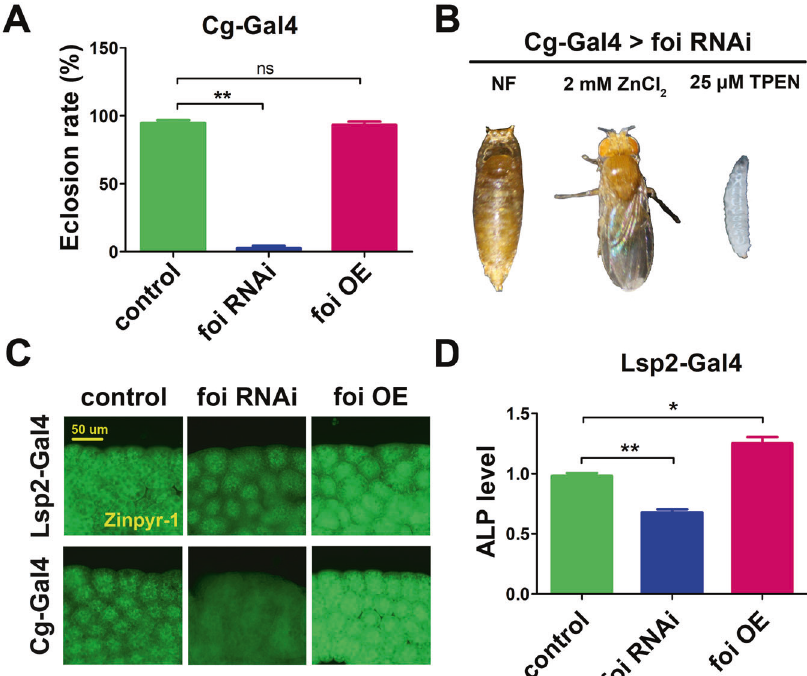
Fig. 1 Foi maintains zinc homeostasis in the fat body and modulates the development of Drosophila melanogaster . A Fat body-speci fi c foi knockdown ( Cg-Gal4 > foi RNAi ) resulted in dramatically reduced eclosion rate in Drosophila . n = 70 larvae per vial, n = 6 vials per group. B The defects of RNA-interference foi ( Cg-Gal4 > foi RNAi ) fl ies could be absolutely rescued by dietary zinc supplementation (2 mM ZnCl 2 ) while aggravated by zinc chelator (25 mM TPEN). C The Zinpyr-1 staining revealed that fat body-speci fi c foi OE resulted in zinc accumulation while foi RNAi decreased zinc particles in the fat body cells. D The activity of ALP was signi fi cantly reduced in Lsp2-Gal4 > foi RNAi larvae while increased in Lsp2-Gal4 > foi OE larvae. w1118 fl ies driven by Cg-Gal4 or Lsp2-Gal4 serve as a blank control. All the experiments were conducted independently at least for 3 times. ns: not signi fi cant, * P < 0.05, ** P < 0.01, *** P < 0.001, two-tailed Student ’ s t